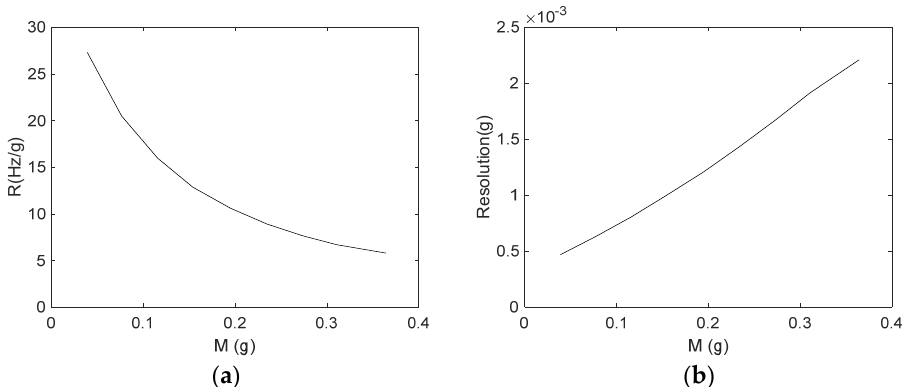
Figure 9. Responsivity ( a ) and resolution ( b ) of the mass sensor estimated in the following operating conditions: B = 0.0948 T and I d = 20 mA.